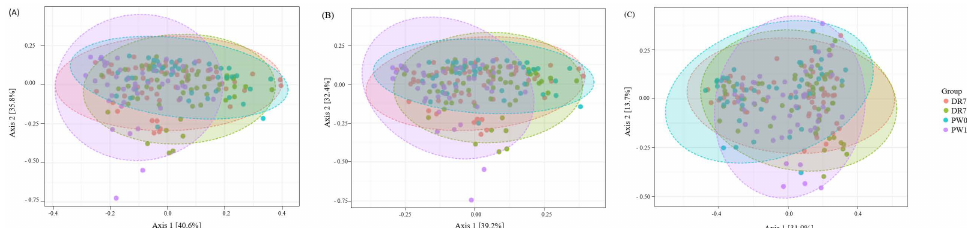
Figure 4. Beta diversity measured by Bray–Curtis dissimilarity and Principal Coordinates Analysis (PCoA) for class ( A ), order ( B ), and genus ( C ) are plotted for stressed adults at baseline (W0) and after week-12 (W12), upon administration of Lactobacillus plantarum DR7 or placebo. Diversity in microbial community composition was achieved by permutational analysis of variance (PERMANOVA) for class, order, and genus. PERMANOVA: class (W0: p = 0.343, W12: p < 0.001), order (W0: p = 0.338, W12: p < 0.001), and genus (W0: p = 0.338, W12: p < 0.001). n = 99 (DR7 n = 55 and placebo n =